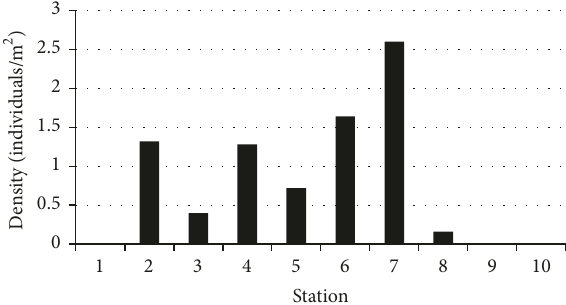
Figure 4: Density of Holothuria leucospilota by station.